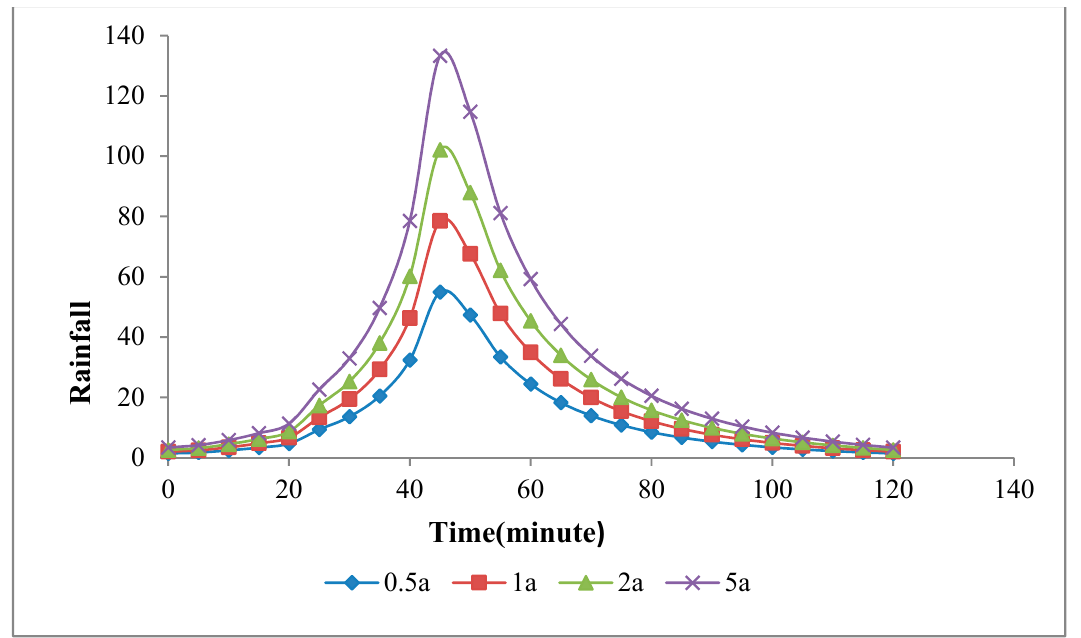
Figure 5. Designed rainstorm